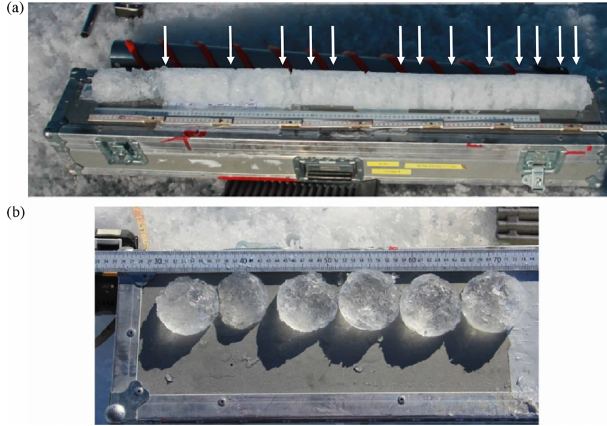
Figure 5. (a) Typical near-surface shallow ice core (core #6) prior to in situ analysis of density and stratigraphy. Clear, solid ice lenses alternate with granular, fractured ice. Approximate locations of ice lenses noted with white arrows (not all lenses are clearly visible). (b) Ice lenses removed and confirmed after completed core analysis (core